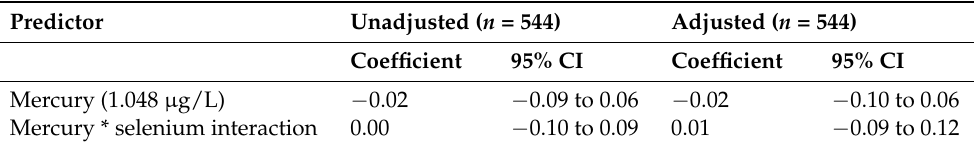
Table 2. Estimated growth (kg) per month between 4 and 61 months in the ALSPAC cohort using mixed effect